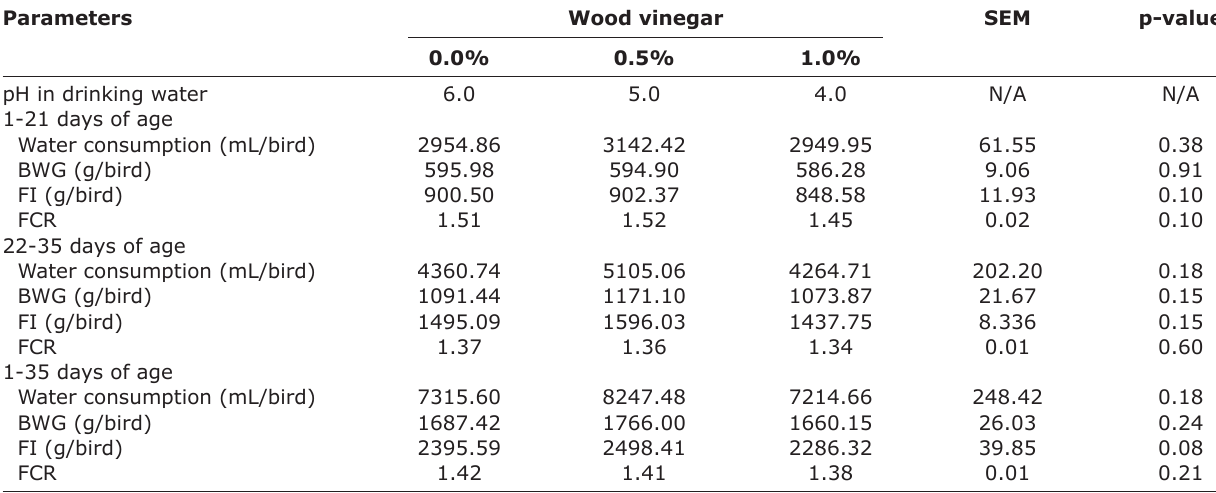
Table-1: Effect of drinking water supplemented with wood vinegar on growth performance of broiler chickens. Parameters